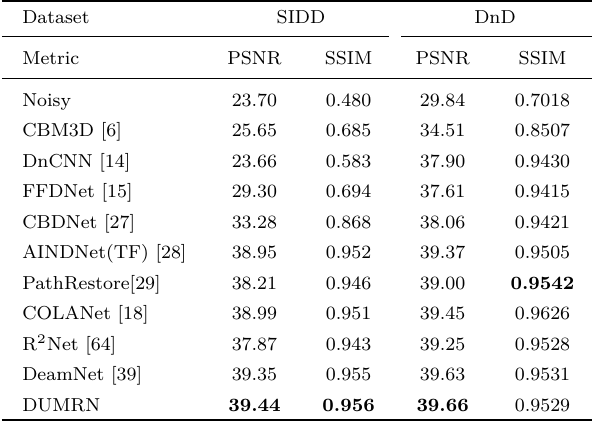
Table 3 Quantitative results for different methods on the SIDD and DnD datasets. Best results are highlighted in bold